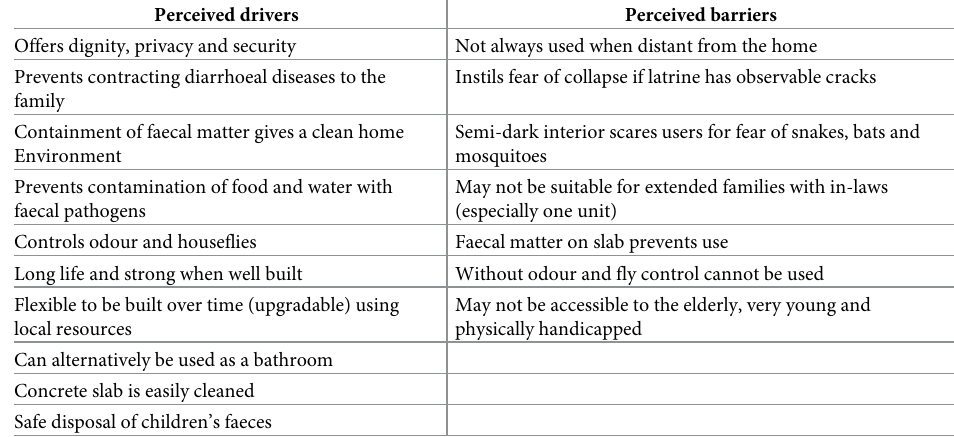
Table 6. Summary of perceived drivers and barriers (multi-level) to users of BVIP latrine from focus groups, Mbire district, northern Zimbabwe